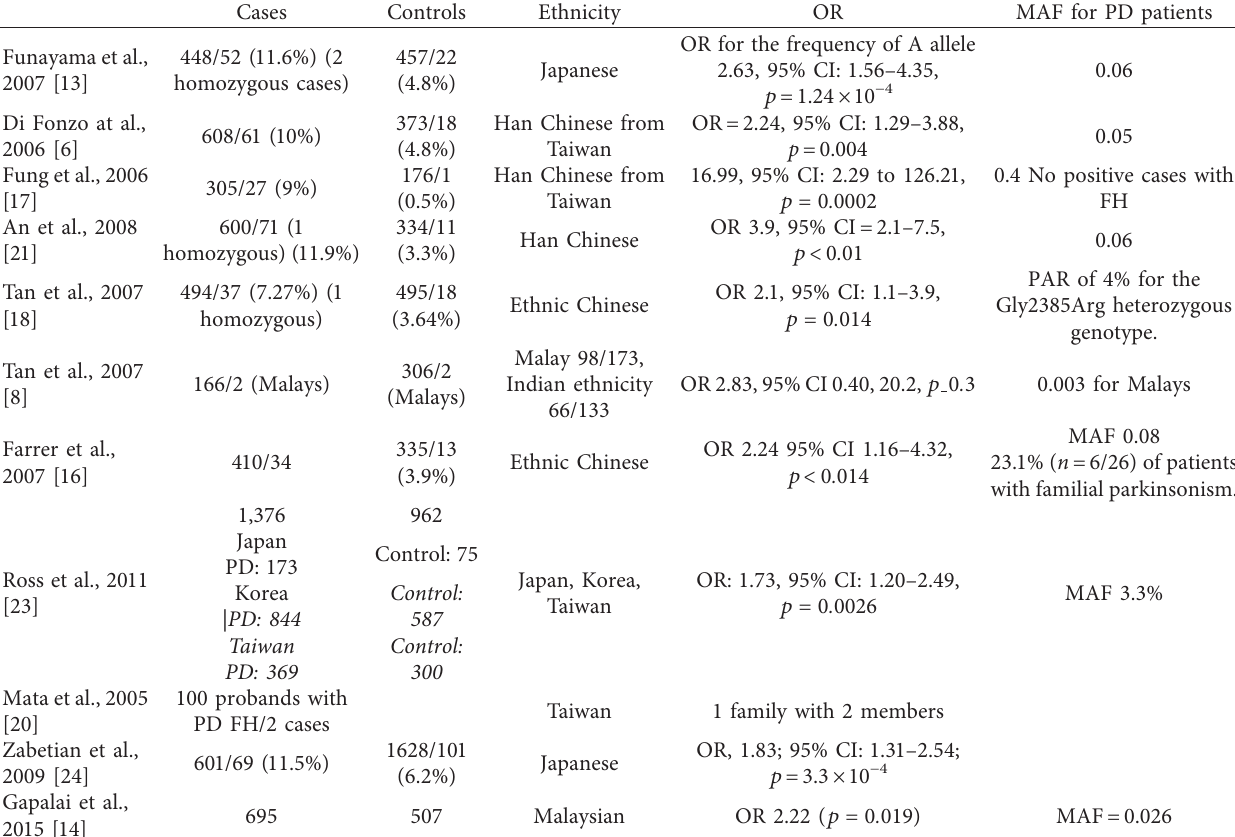
Table 6: Studies investigating LRRK2 p.Gly2385Arg variant in Asian